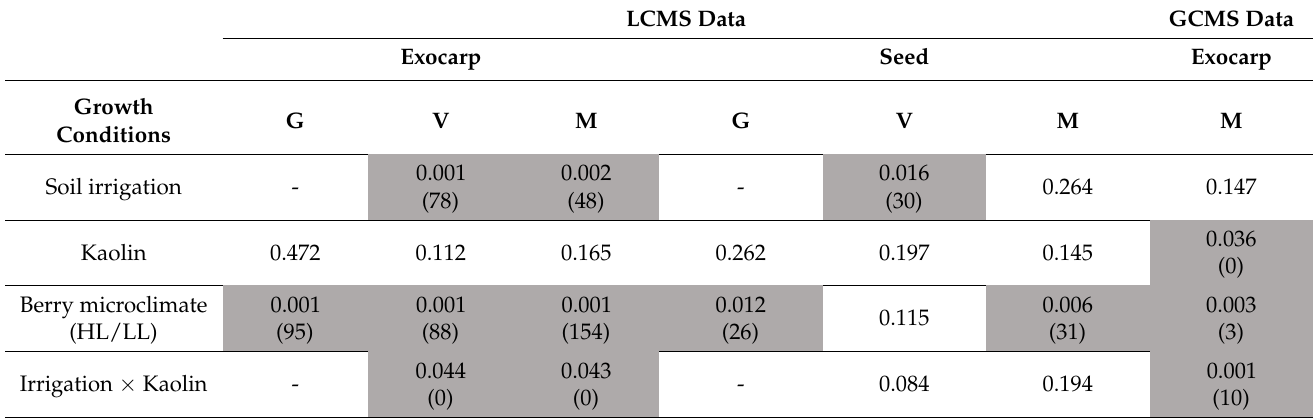
Table 1. Levels of significance ( p values) obtained by ANOVA simultaneous component analysis (ASCA), for the effects of the various growth conditions and their interactions on the exocarp and seed metabolite composition, based on either the LCMS or GCMS analysis, during berry ripening (G—Green, V— V é raison , M—Mature). Significant effects ( p ≤ 0.05) are highlighted by the grey color; interactions that appear insignificant were omitted. The numbers between brackets indicate the total number of significant (FDR-adjusted p ≤ 0.05) metabolites from N-way